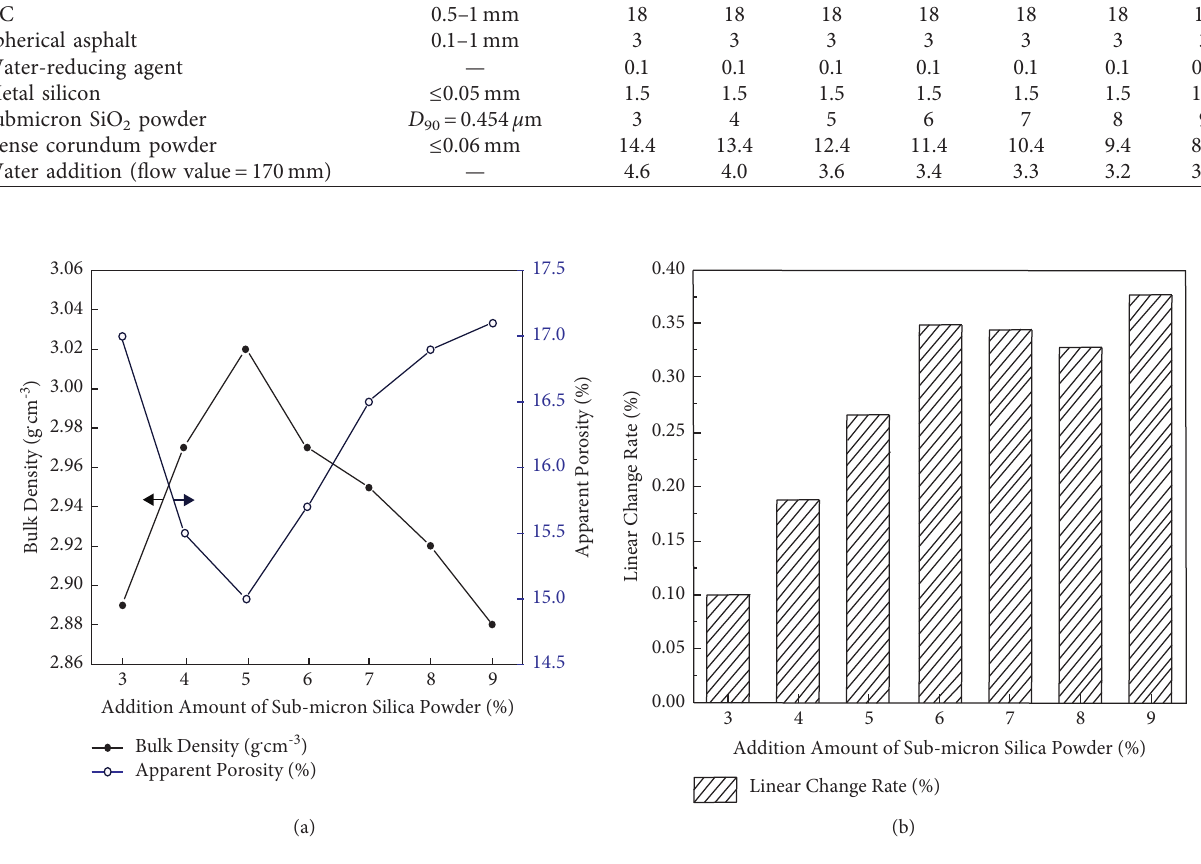
Figure 3: Physical properties of samples sintered at 1450 ° C for